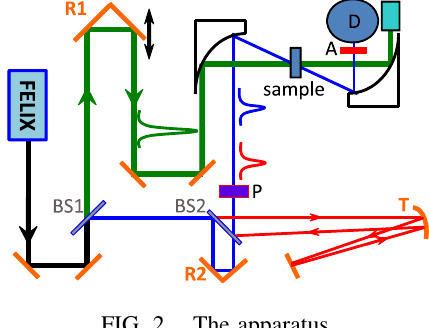
FIG. 2. The apparatus.